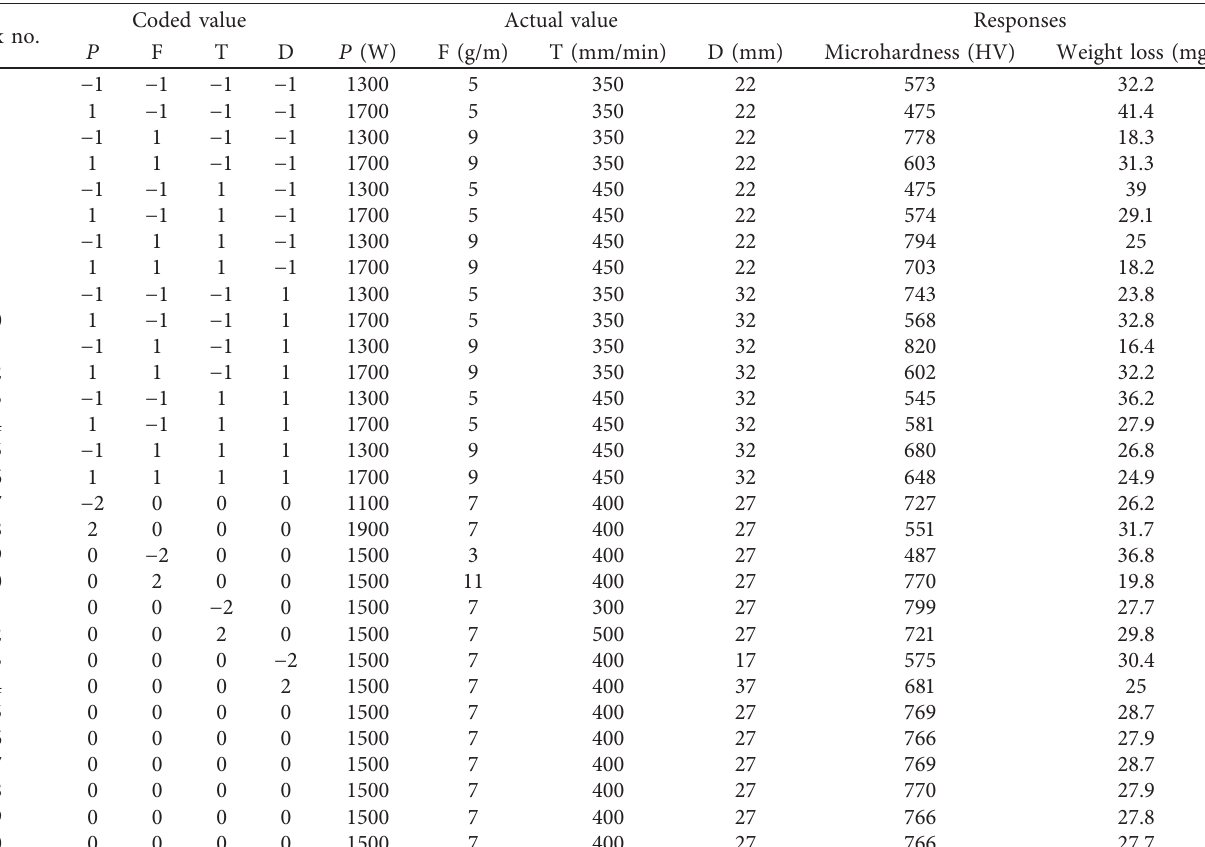
Table 3: Design matrix and experimental